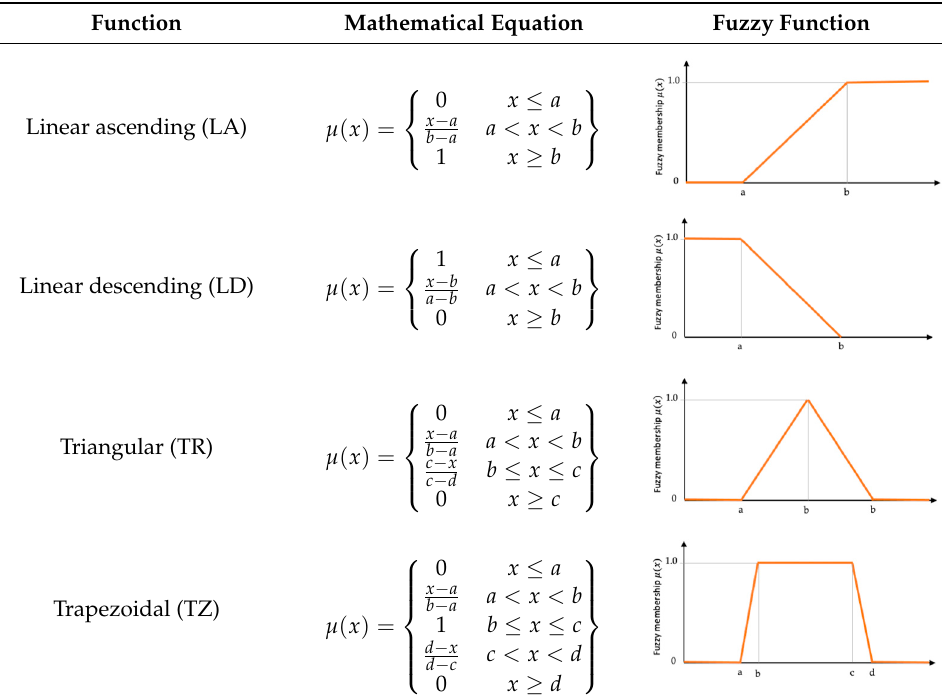
Table 1. Fuzzy membership functions [29,52].